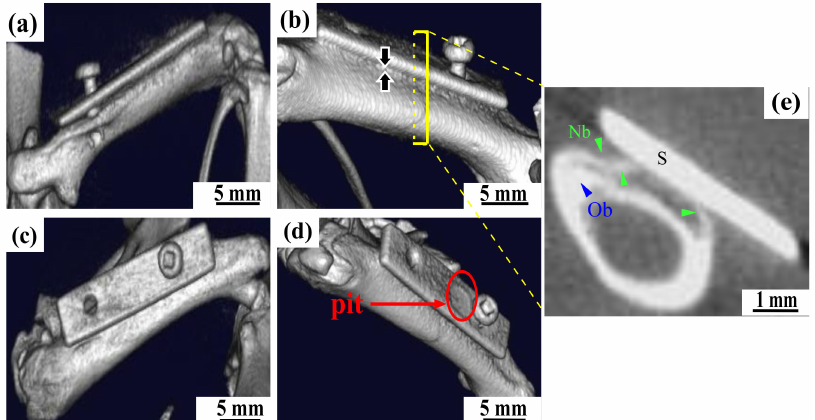
Figure 10. Determination of the volume of the degrading Mg-RE alloy sheet and bone growth changes, depicted in MicroCT 3D rendering after implantation times of 2 weeks ( a , c ) and 6 weeks ( b , d ). A cross section slice of femoral-sheet contact area observed after 6 weeks ( e ) shows that the new bone (Nb is represented in green) was formed between the Mg-RE alloy sheet (S) and the original bone (Ob is represented in blue).